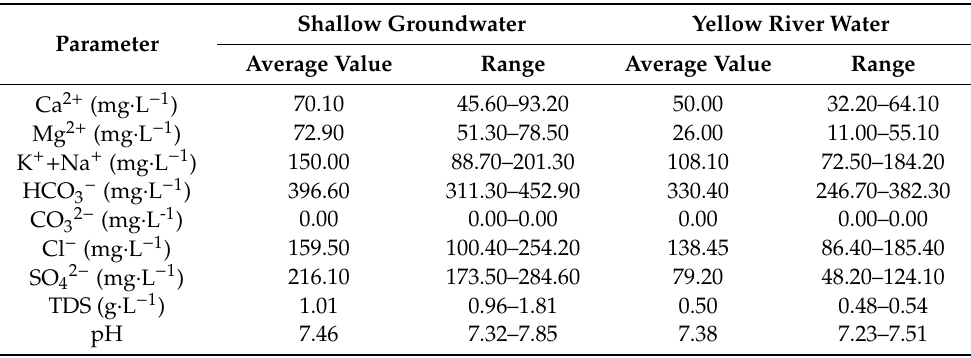
Table 5. Compounds dosage for different water salinity levels.